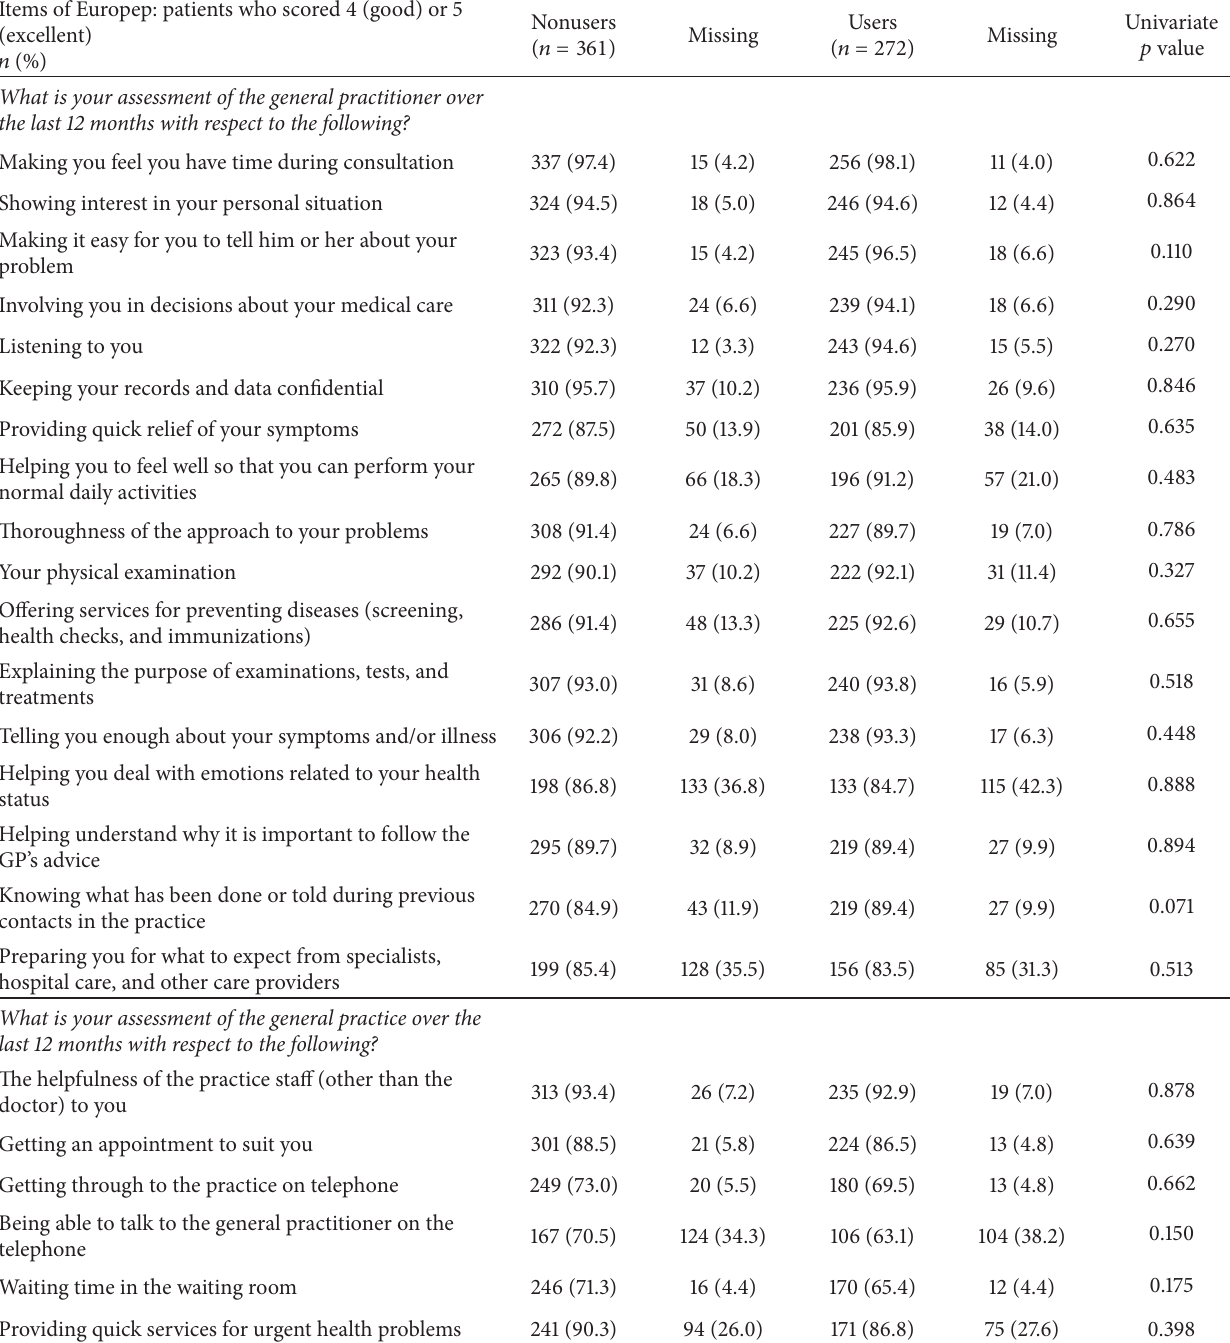
Table 7: Scores on quality of care (Europep) of users and